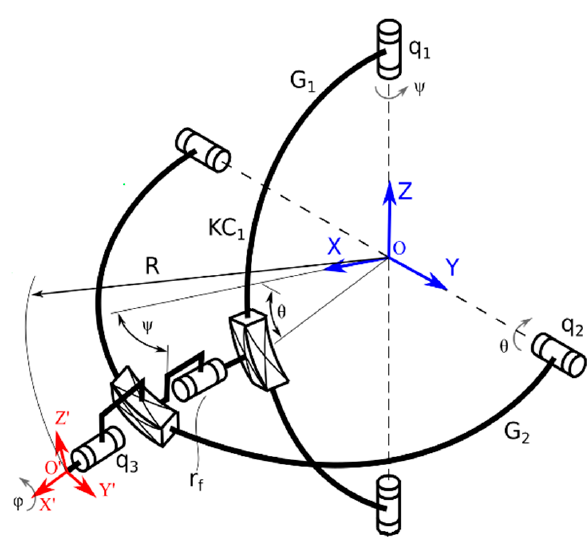
Figure 2. The kinematic scheme of ASPIRE. The initial experimental model of ASPIRE is presented in Figure 3. Along with the kinematic elements needed for the rehabilitation motion of the shoulder, other aiding elements were added. The frame of the robotic structure was made of aluminum profiles, and the case of the robot was made of Plexiglas. The circular guides were manufactured from aluminum, and the sliding carriages were 3D-printed and properly greased to ensure a low friction coefficient. The shoulder rest was also 3D-printed in such a manner to ensure the support of the shoulder during the flexion and extension motions. The forearm support was 3D-printed and embedded into an adjustment mechanism to fit different lengths of the forearm. The palm rest was made of aluminum and embedded into the pronation/supination mechanism. The connection between the vertical circular guide and the horizontal one was made using a passive revolute joint between the circular guides. An actuated height adjustment mechanism was added to allow easy setup of the robot between patients of different heights.